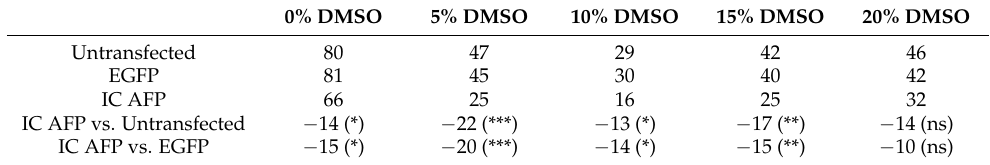
Table 2. Average LDH release of HEK 293T cells across treatments expressed as % total cellular LDH. 0% DMSO 5% DMSO 10%